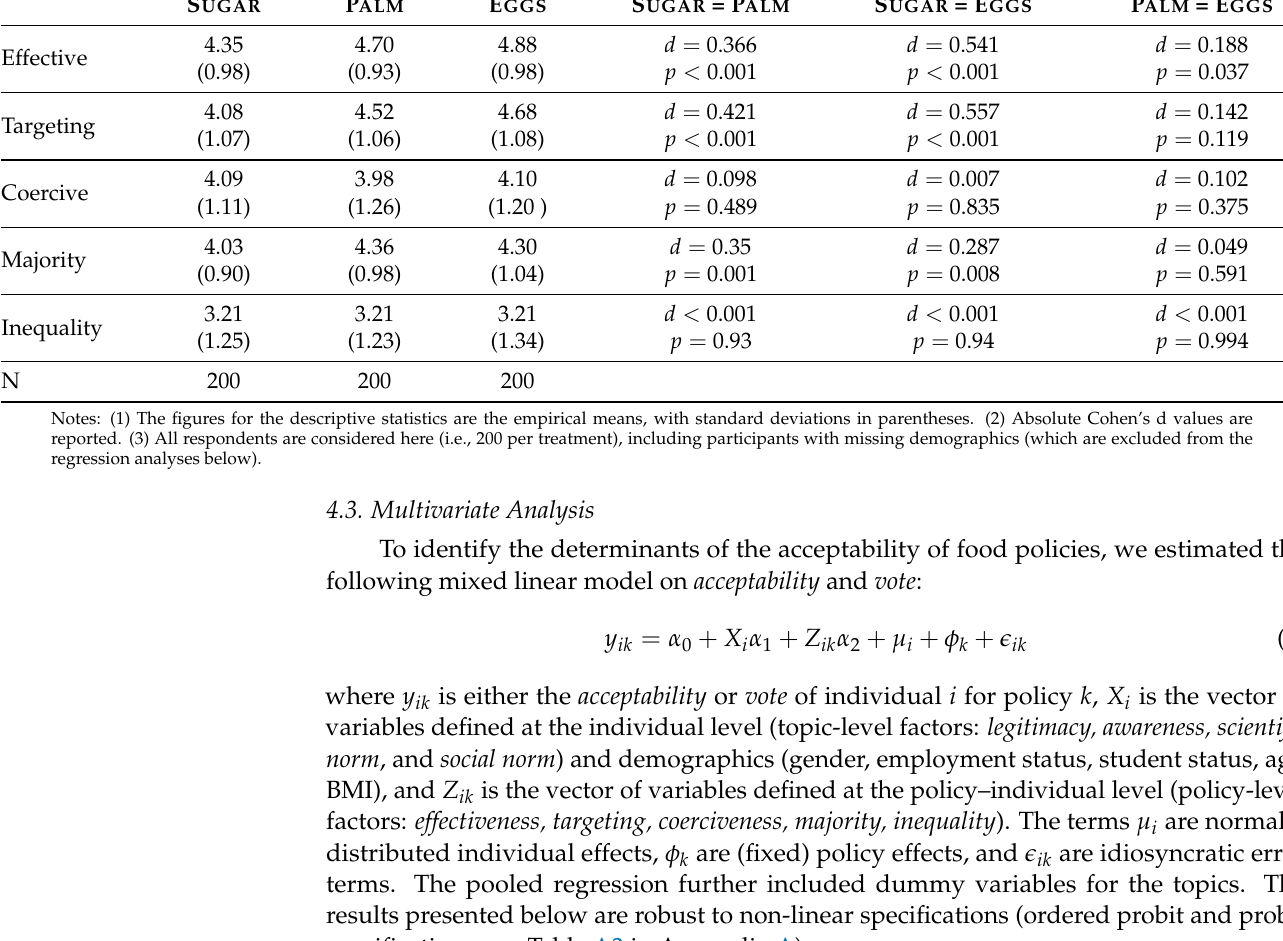
Table 5. Descriptive statistics for policy-level factors averaged over the six policies. Descriptive